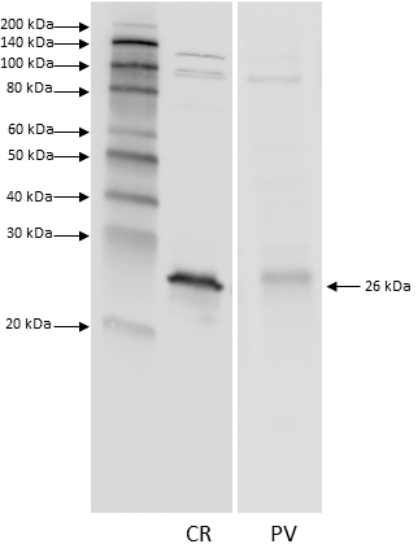
Figure 2. Immunoblot analysis revealed the presence of both parvalbumin (PV) and calretinin (CR) in the motor cortex. A single immunoreactive band at about 26 KDa was detected for anti-CR and for anti-PV, the latter probably representing a dimeric form of PV.